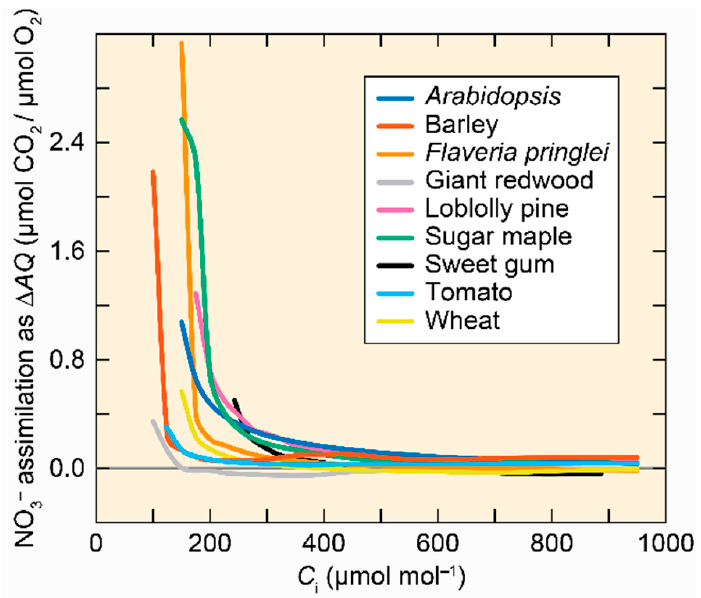
Figure 5. Shoot NO 3– assimilation as a function of shoot internal CO 2 concentration ( C i ) for 9 C 3 species. Adapted with permission from ref. [101]. Copyright 2014 Springer Science Business Media Dordrecht.